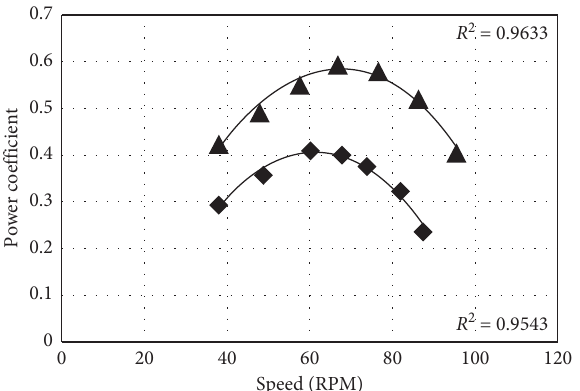
Figure 32: Runner 15 data points.